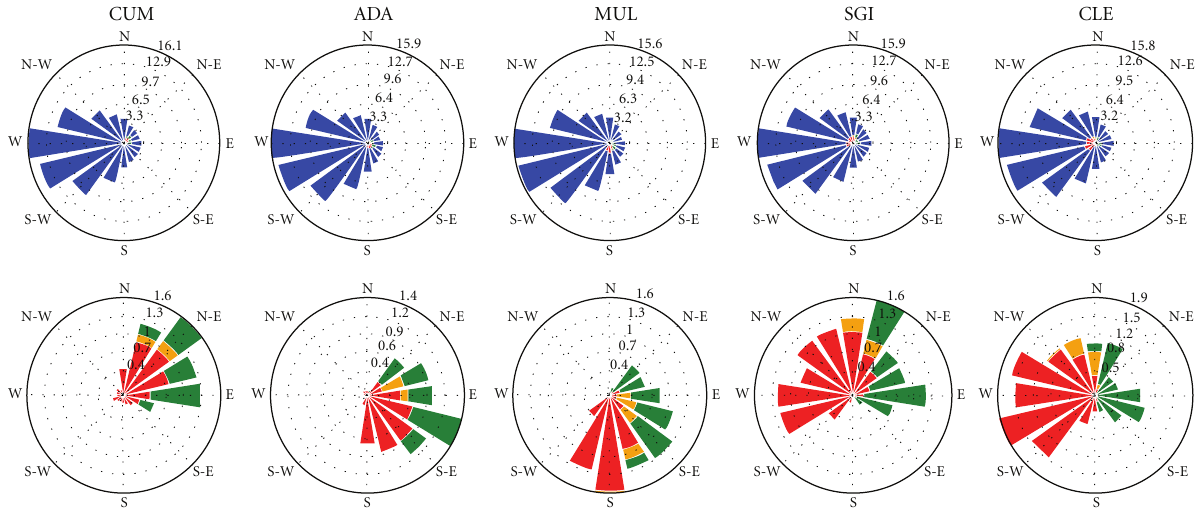
Figure 2: Upper: wind rose source-receptor plots showing the proportion (%) of air by direction and source (Republic of Ireland (red), Northern Ireland (orange), Great Britain (green) and marine and other regions (blue)) arriving at the study catchments (receptors; arrival height of 850 hPa) based on two-day back trajectories estimated every six hours during the period